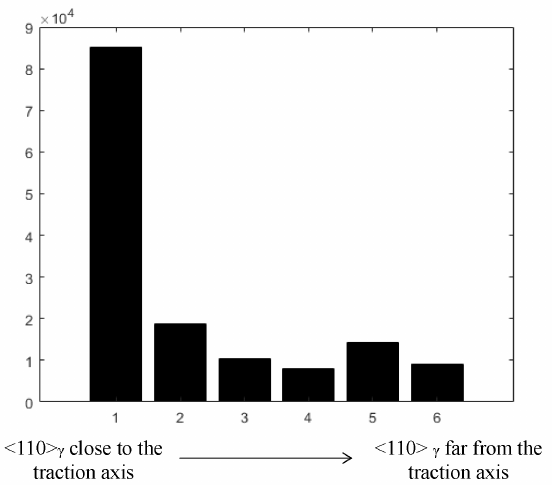
Figure 7. Histograms of plate group occurrence considering a ranking based on the empirical criterion. In the y -axis: the number of pixels associated with a given plate. In the x -axis: plate group numbered with a ranking according to the empirical